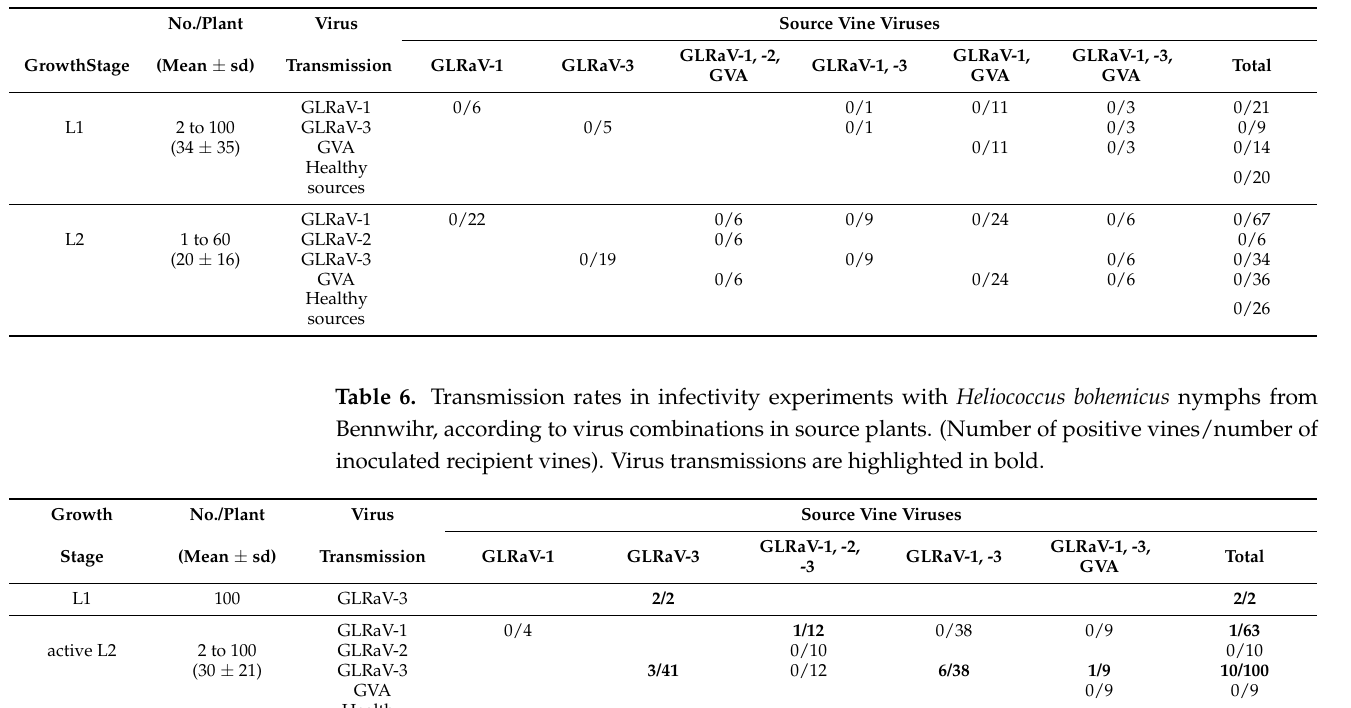
Table 5. Transmission rates in infectivity experiments with Heliococcus bohemicus L1 and L2 nymphs from five locations (Colmar, Kientzheim, Turckheim, Nothalten, and Ribeauvill é ), according to virus combinations in source plants. (Number of positive vines/number of inoculated recipient vines).